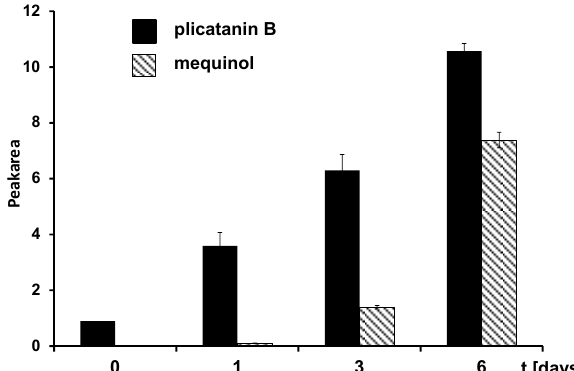
Figure 4. Increase of the peak areas of plicatanin B ( 8 ) and mequinol ( 9 ) upon fermentation of M. perennis aqueous root extracts with Pediococcus sp. (PP1). Peak areas were measured by GC-MS analysis of AcOEt extracts and calculated based on the internal standard eicosane ( n -C 20 ); STD ( n = 3).